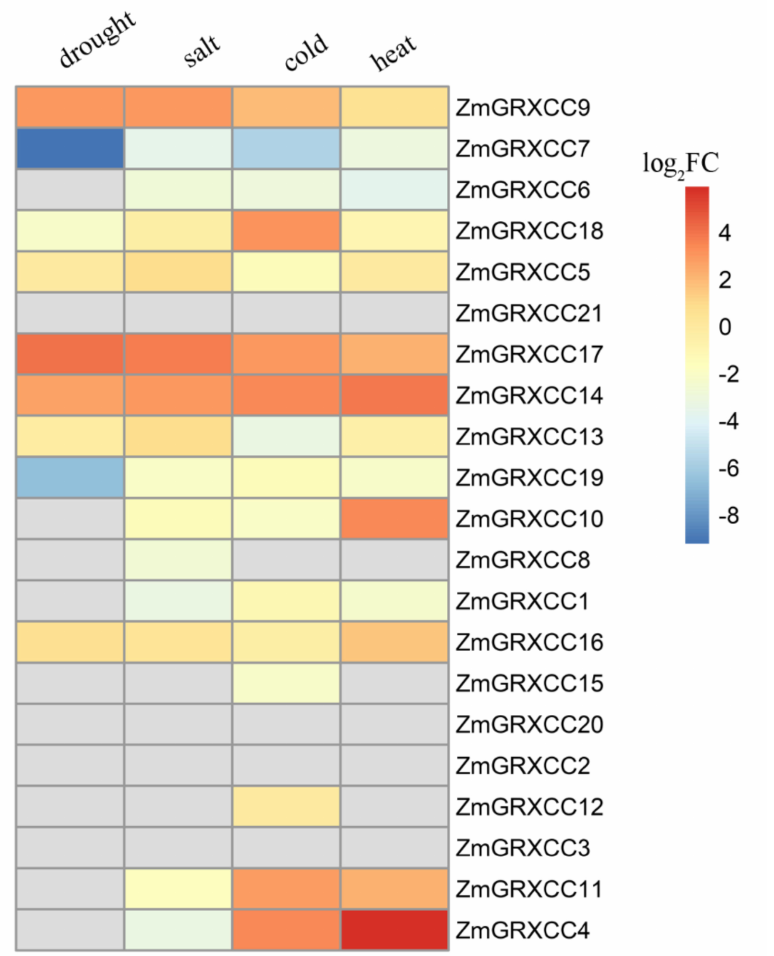
Figure 5. Transcriptomic analysis of ZmGRXCC genes. The log2-based fold change (FC) values were supplied to build the heatmap. The color scale ranged from blue, representing low expression, and passes through white and finally to red, representing high expression. The gray color shows missing